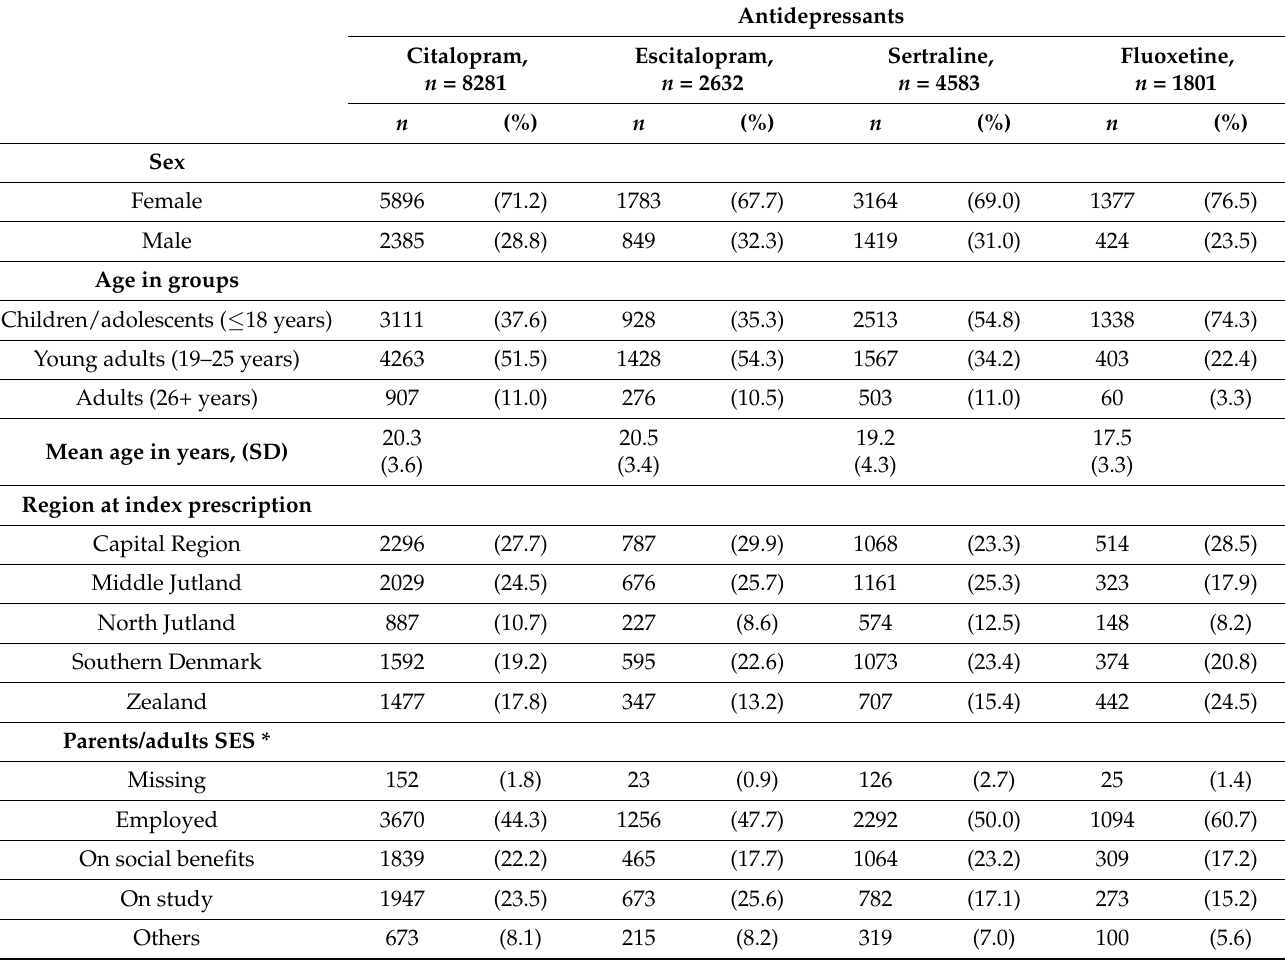
Table 1. Baseline characteristics at the index date of the first-time prescription of sertraline, escitalo- pram, citalopram, and fluoxetine of the total study population ( n = 17,297) of all individuals born between 1981 and 2005 with a depression diagnosis any time between 1996 and